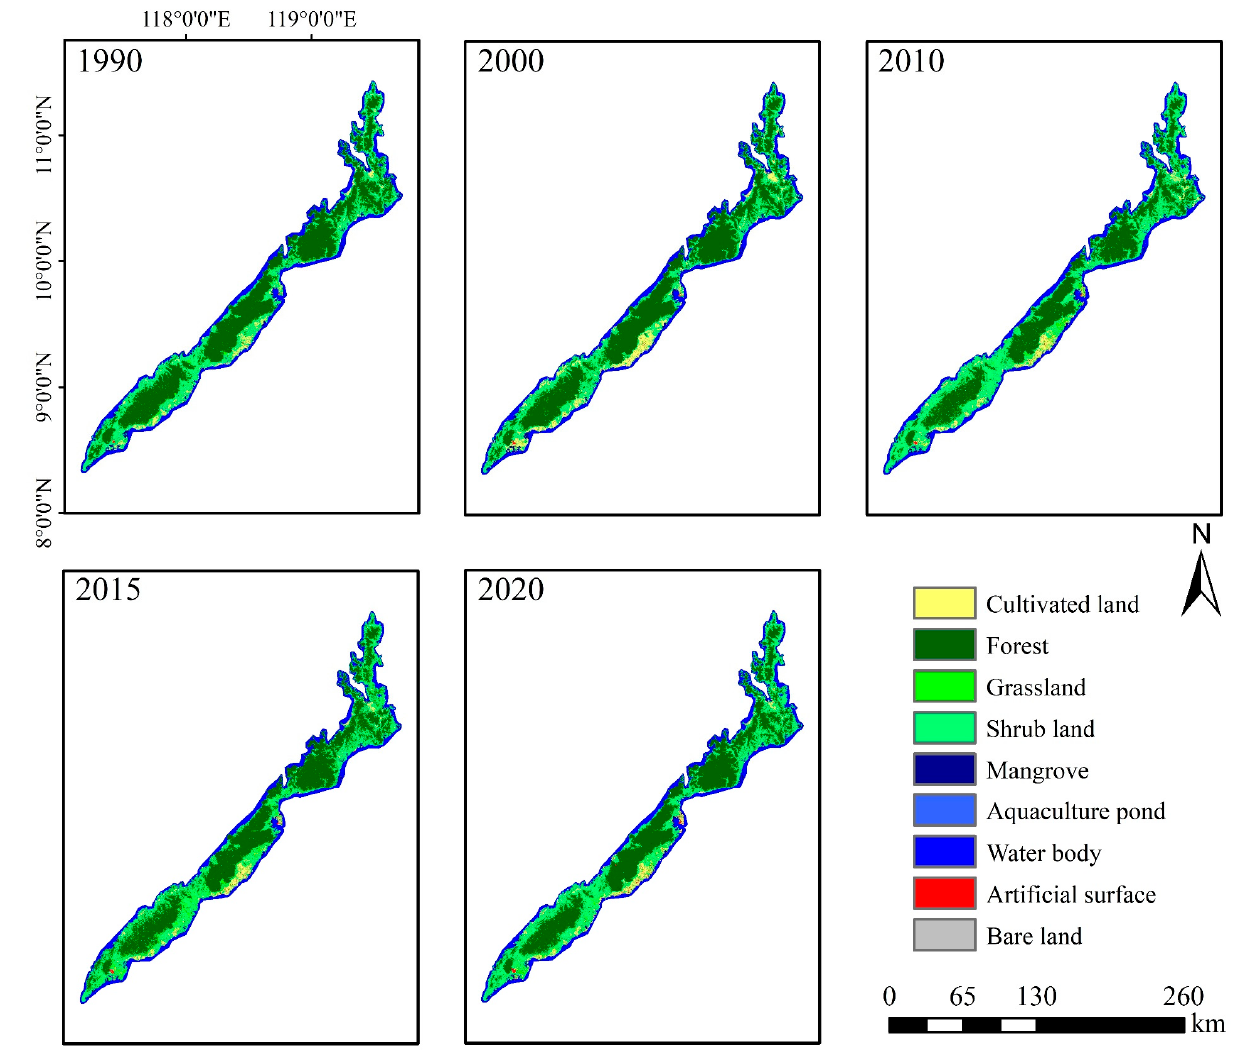
Figure 6. Spatial distribution of land cover in Palawan from 1990 to 2020.